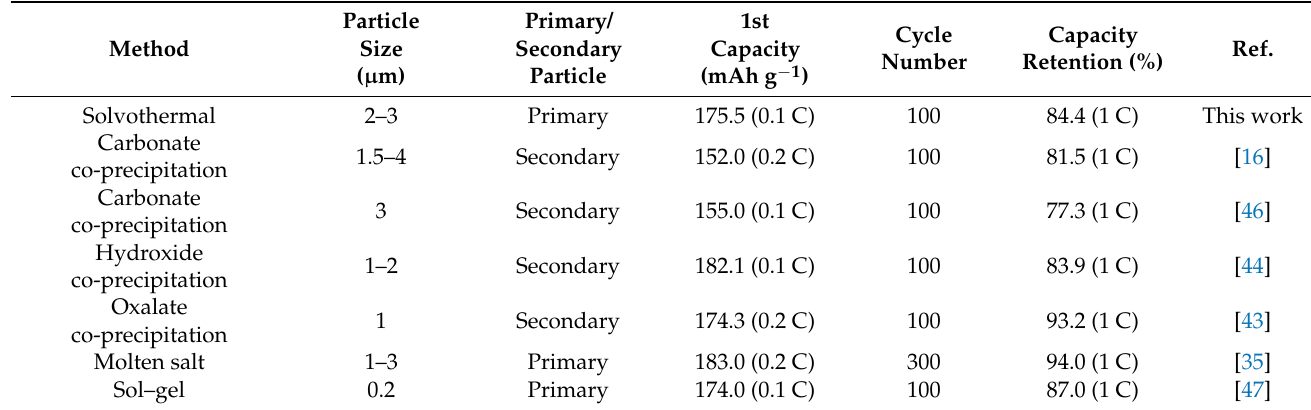
Figure 8. ( a ) The cycling performance of NCM622 at different sintering temperatures at 1 C for 100 cycles, and corresponding charge–discharge curves of ( b ) NCM750, ( c ) NCM800, and ( d ) NCM850 at 1 C for the 1st, 5th, 10th, 20th, 50th, and 100th cycles. Table 2. Comparison of electrochemical performance of NCM622 cathode materials in this work with those of previously reported